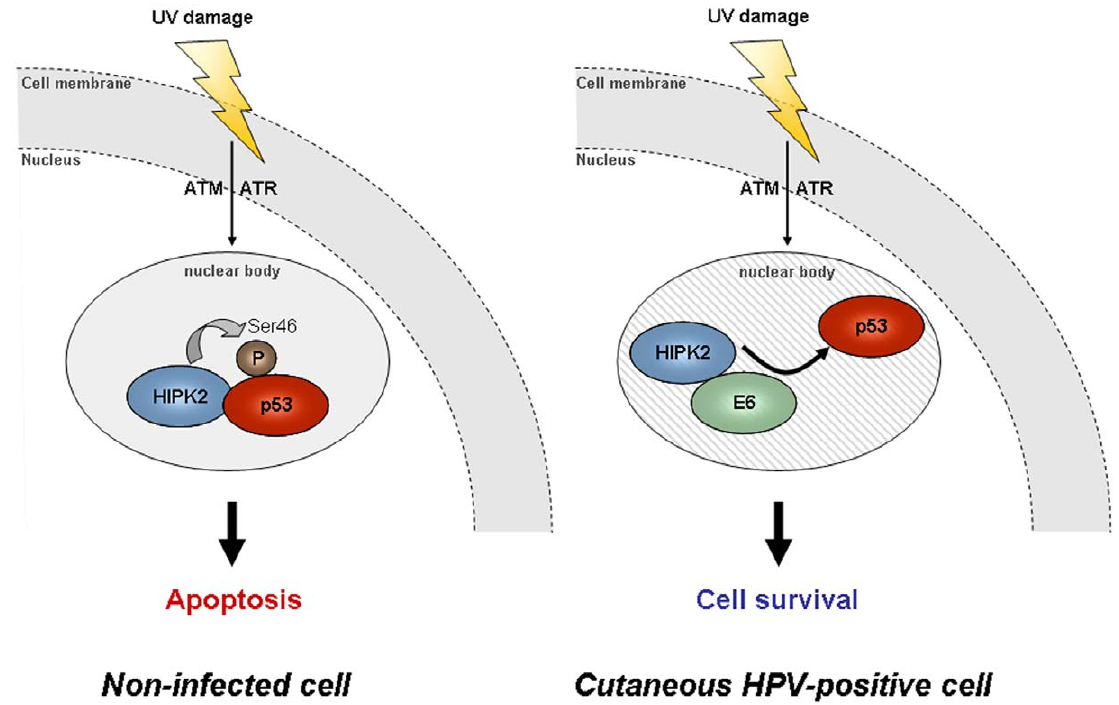
Figure 6. Proposed model for HPV23 E6 inhibition of the HIPK2/p53 complex upon UV-induced DNA-damage. In response to DNA damage, checkpoint kinases ATM and/or ATR mediate HIPK2 stabilization and activation . In response to lethal DNA damage, HIPK2 activates apoptosis by phosphorylation of p53 at Ser 46 in nuclear bodies. In HPV infected cells, HPV23 E6 binds HIPK2 and dissociates the HIPK2/p53 complex. E6 binding to HIPK2 inhibits the phosphorylation of p53 at Ser